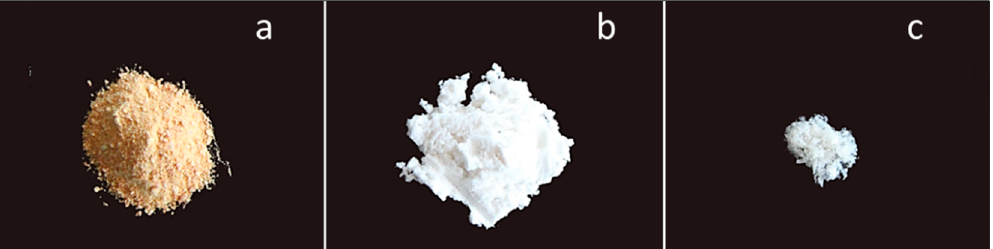
Figure 1. The visual appearance of ( a ) raw orange peel powder, ( b ) orange peel cellulose, and ( c ) cellulose nanocrystals.